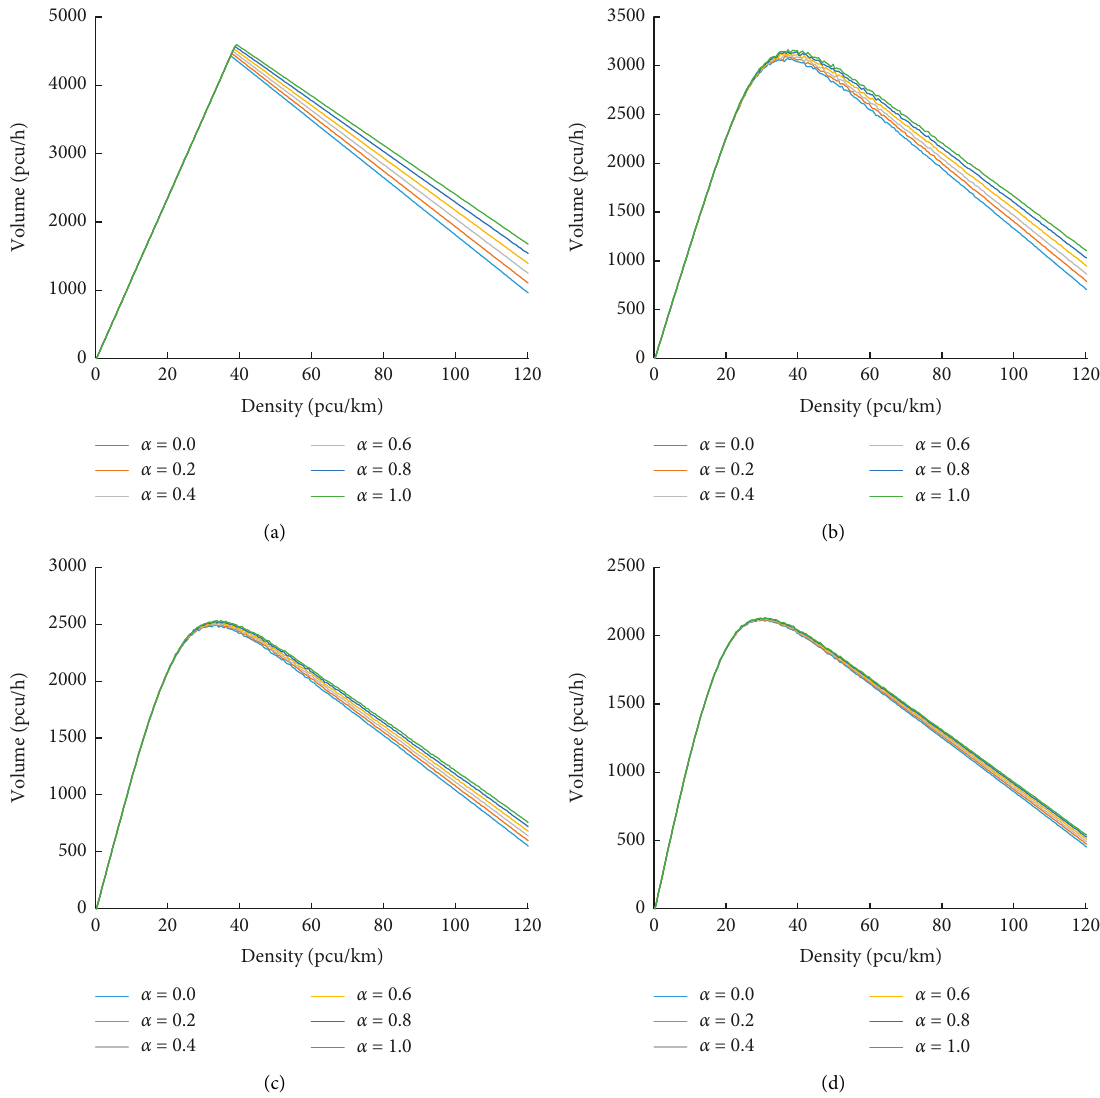
Figure 11: Traffic capacity with multiple penetration rates under bogus messages. (a) No HDVs. (b) 25% HDVs. (c) 50% HDVs. (d) 75%